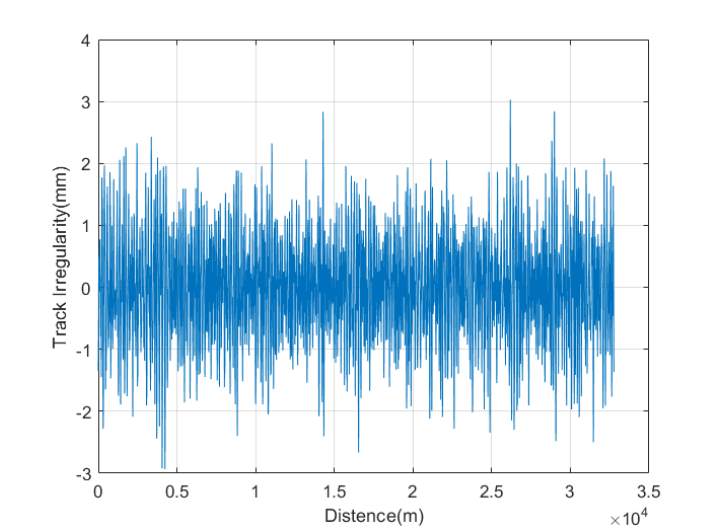
Figure 6. Track irregularity data in numerical simulation.